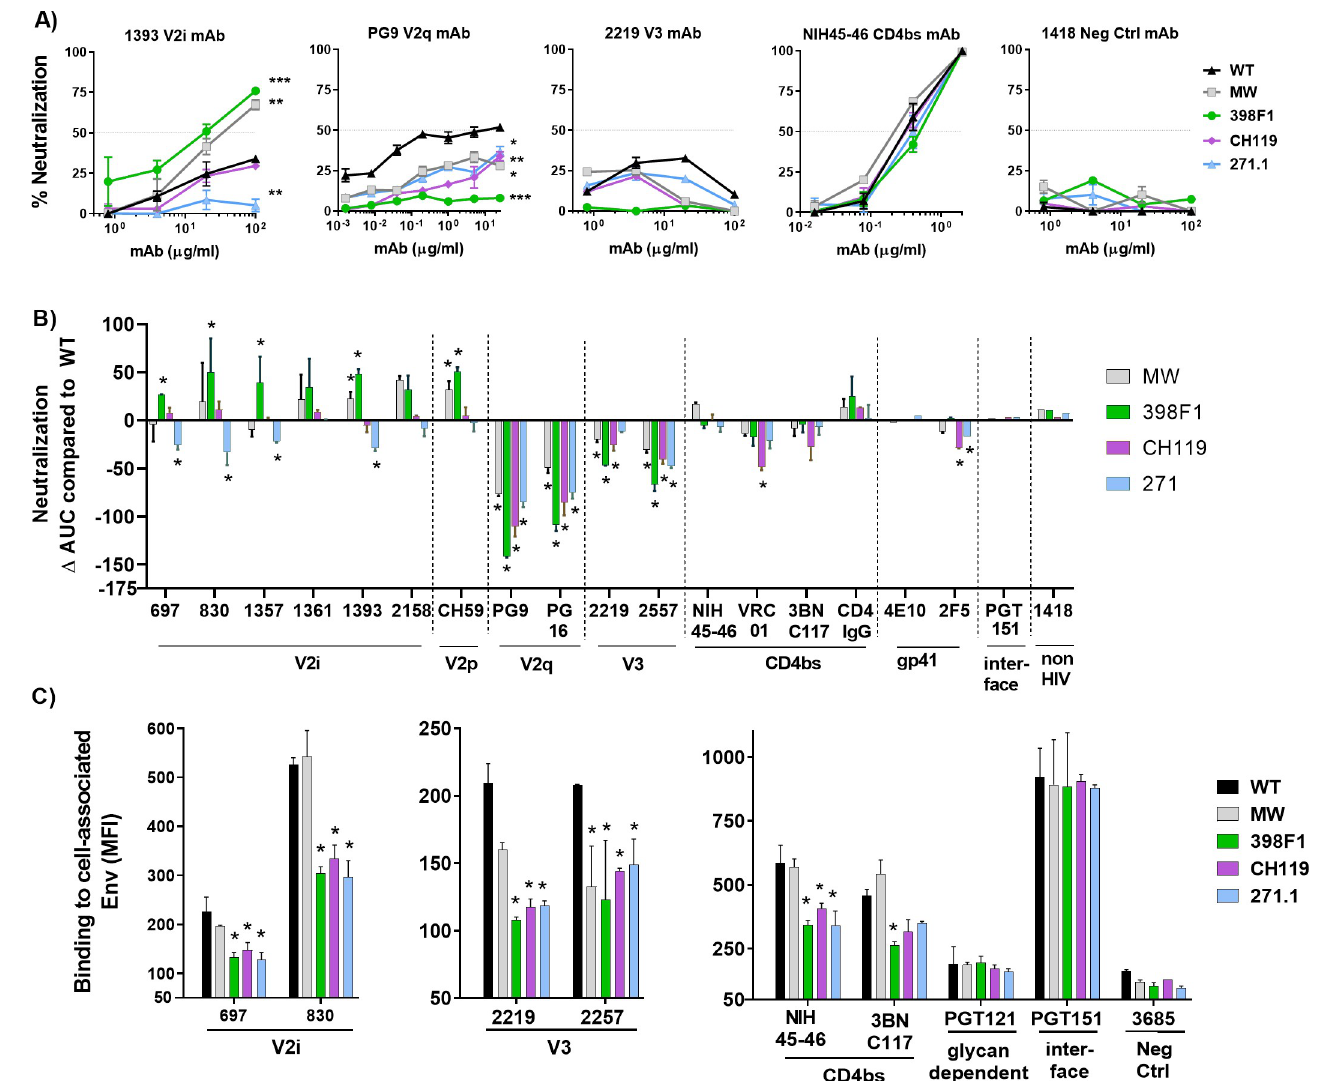
Fig 9. Effect of SP swap on neutralization of CMU06 produced in PBMCs and antigenicity of CMU06 Env expressed on human CD4 + T cells. (A) Virus neutralization was measured using TZM.bl cells. MAb 1418 served as a negative control. Neutralization curves of selected virus-mAb pairs are shown. � , p < 0.05; �� , p < 0.01; ��� , p < 0.001 vs WT by 2-way ANOVA (B) Changes in neutralization AUCs of SP-swapped vs WT viruses by different mAbs. Statistical analysis was performed on neutralization curves as in Fig 4A by 2-way ANOVA ( � p < 0.05) (C) Binding of mAbs to Env expressed on CD4 + T cell surface. MAbs were tested at the following concentrations: 697, 830, 2219 and 2557 and 3685 at 100 μ g/ml; PGT121 25 μ g/ml; CH59 and PGT151 at 10 μ g/ml; NIH45-46 at 2.5 μ g/ml; 3BNC117 at 20 μ g/ml. MFI and SD from duplicates of one experiment are shown. � , p < 0.05 vs WT by ANOVA.